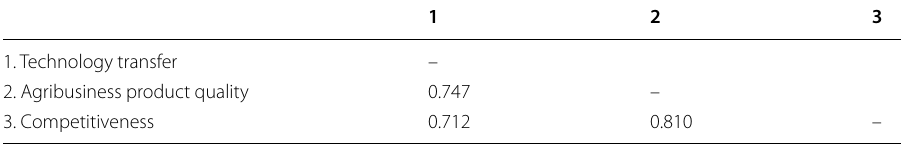
Numbers on the first row refer to corresponding variables on the first column